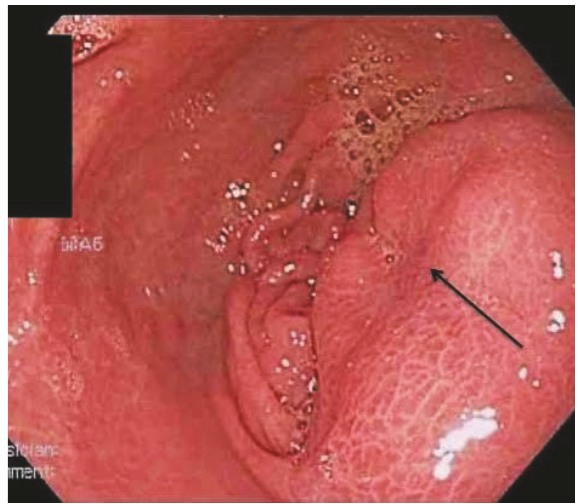
Figure 1: Firm submucosal mass with intact overlying mucosa and a central